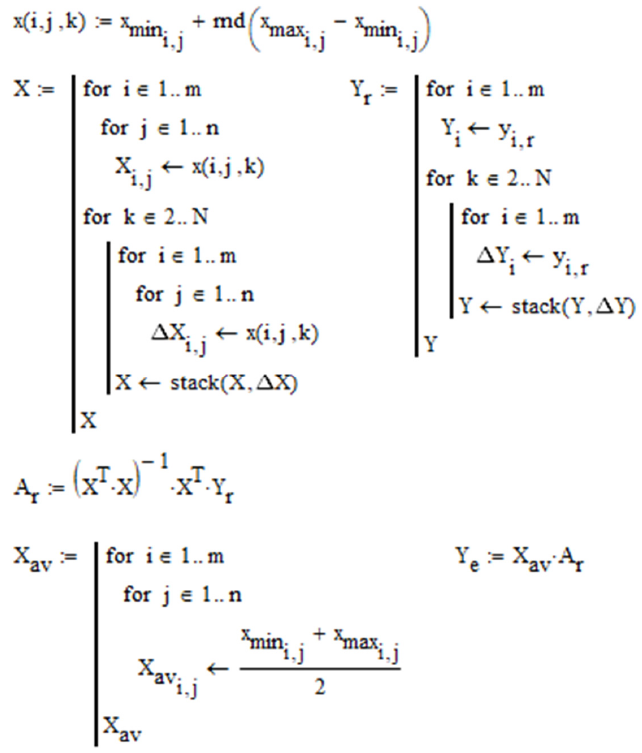
Figure 2. Program realization using the computer algebra system MathCAD.